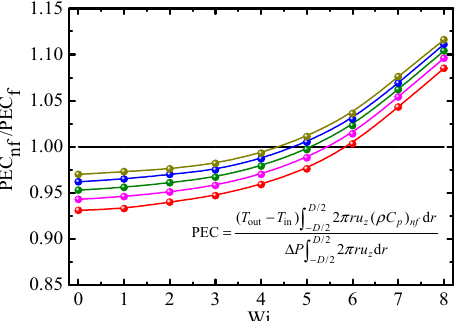
Figure 12. PEC nf /PEC f vs. Weissenberg number for different particle concentrations ( β 0 = 0.2, Re = 2.5, α = 0.2). — • —: Φ = 0% (Giesekus fluid); — • —: Φ = 0.5% (Giesekus fluid); — • —: Φ =